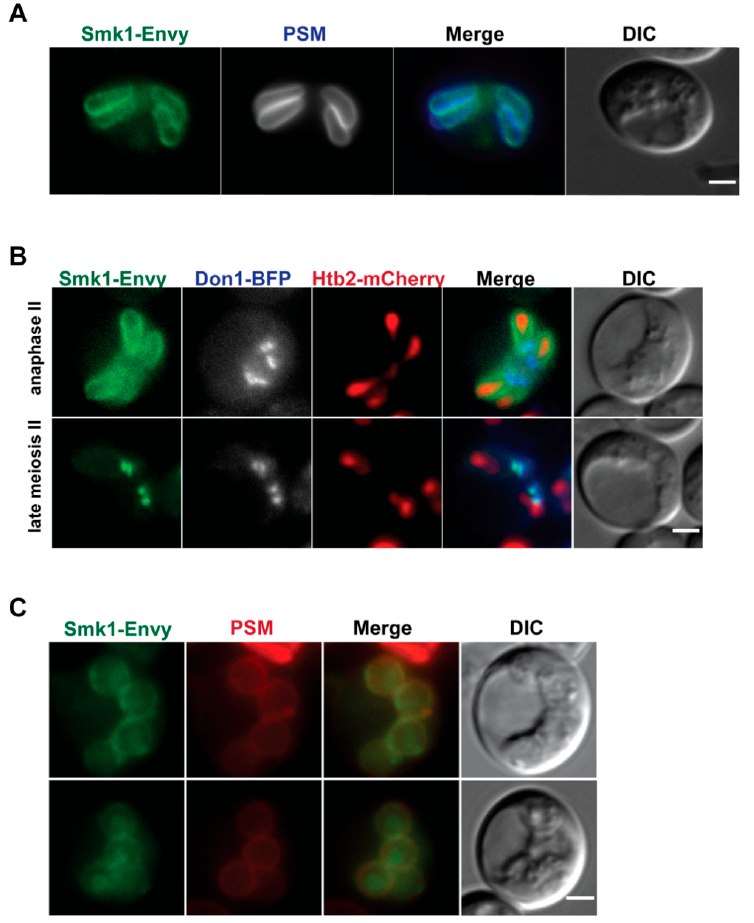
Figure 1. Smk1 exhibits two distinct localizations during prospore membrane development. ( A ) Smk1-GFP Envy co-localizes with the prospore membrane (PSM) marker pRS426-Spo20 51–91 - mTagBFP along the PSM. ( B ) Smk1-GFP Envy localizes to PSM during the elongation stage of mem- brane development, and is concentrated at the leading edge of the prospore membrane after anaphase II. Htb2-mCherry is used as a histone marker. The leading edge of the growing prospore membrane is marked using Don1-BFP. ( C ) Smk1-GFP Envy becomes more broadly localized after prospore membranes round up and close. Prospore membranes are in red and are labeled using an integrated Spo20 51–91 -mKate2 marker. For all strains, the genomic copy of SMK1 is epitope tagged with GFP ENVY at its C-terminus; strains are homozygous for SMK1-GFP ENVY . Yeast strains used for each panel: ( A ) LH1116, ( B ), LH1117, and ( C ) LH1133. Scale bar = 2 µM.